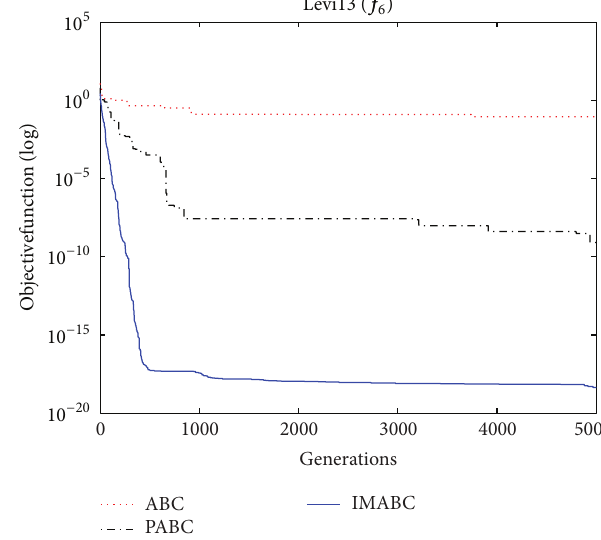
Figure 6: 𝑓 4 function convergence performance comparison.